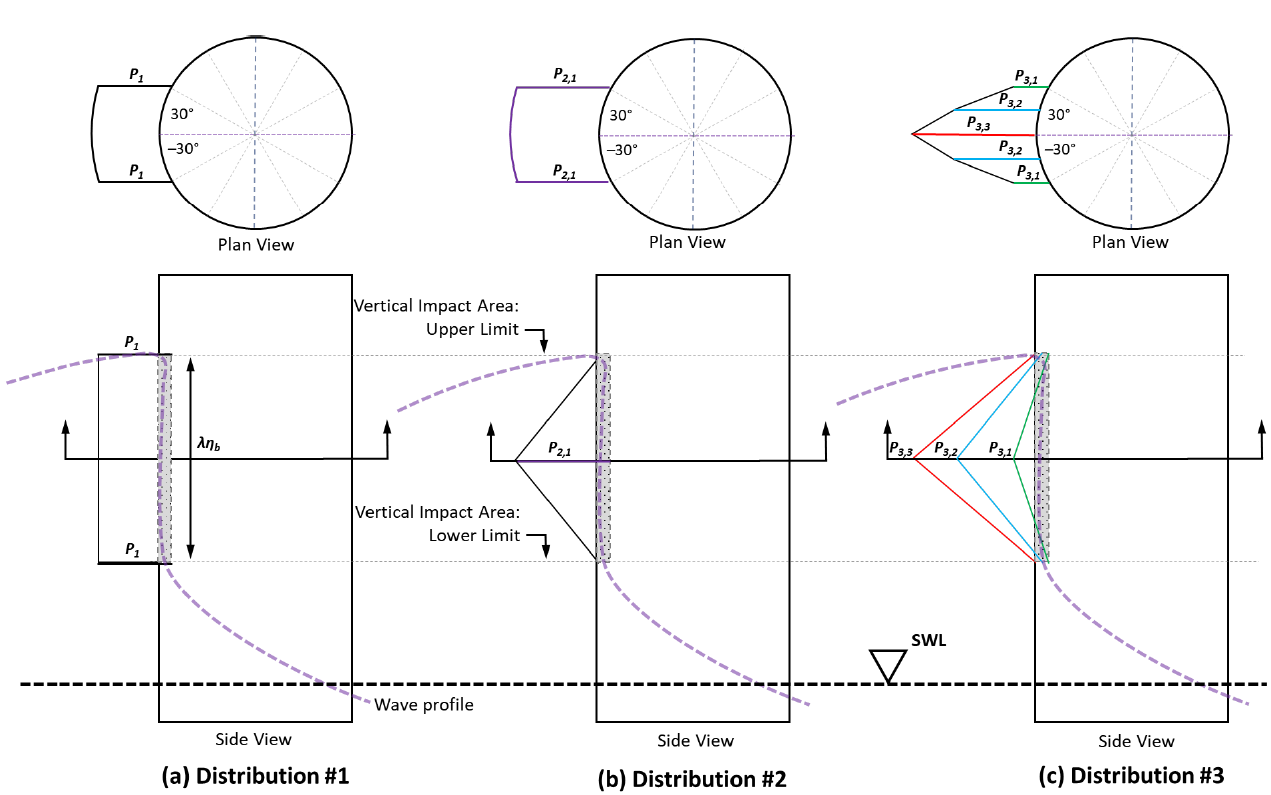
Figure 4. Pressure distribution scenarios definition sketch (adopted from Wienke and Oumeraci (2005) [3]).